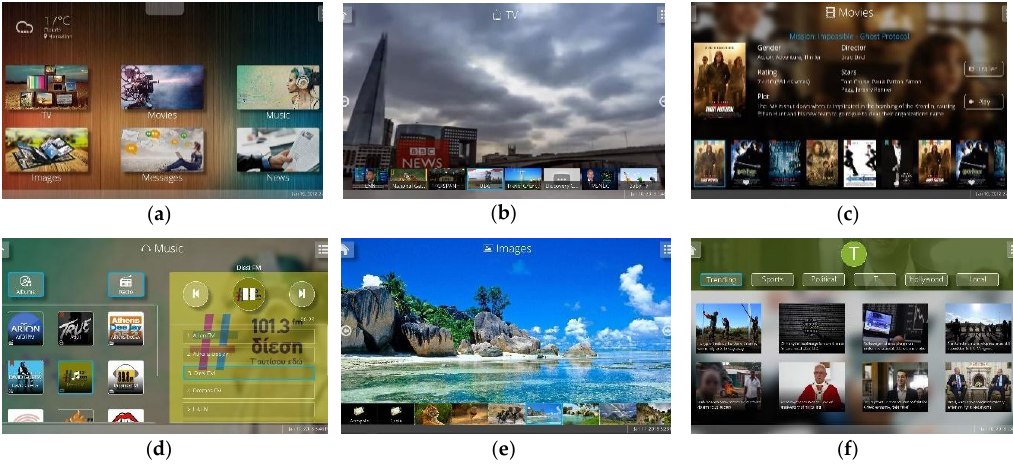
Figure 5. AmI TV instances: ( a ) Home Screen; ( b ) TV application; ( c ) Movies application; ( d ) Music application; ( e ) Images application; ( f ) News application.